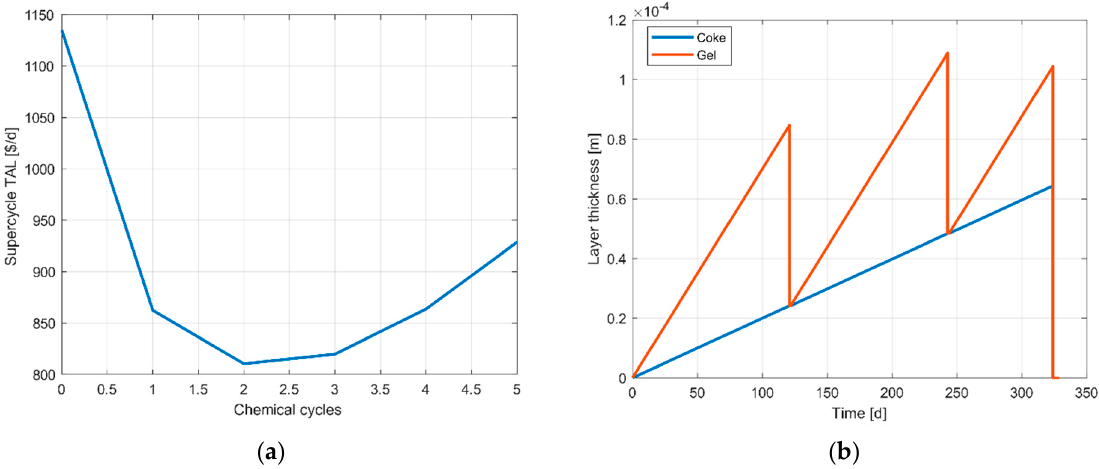
Figure 6. Supercycle optimal scheduling: ( a ) TAL vs. number of solvent cleaning N C ; ( b ) Supercycle layer thickness trend.